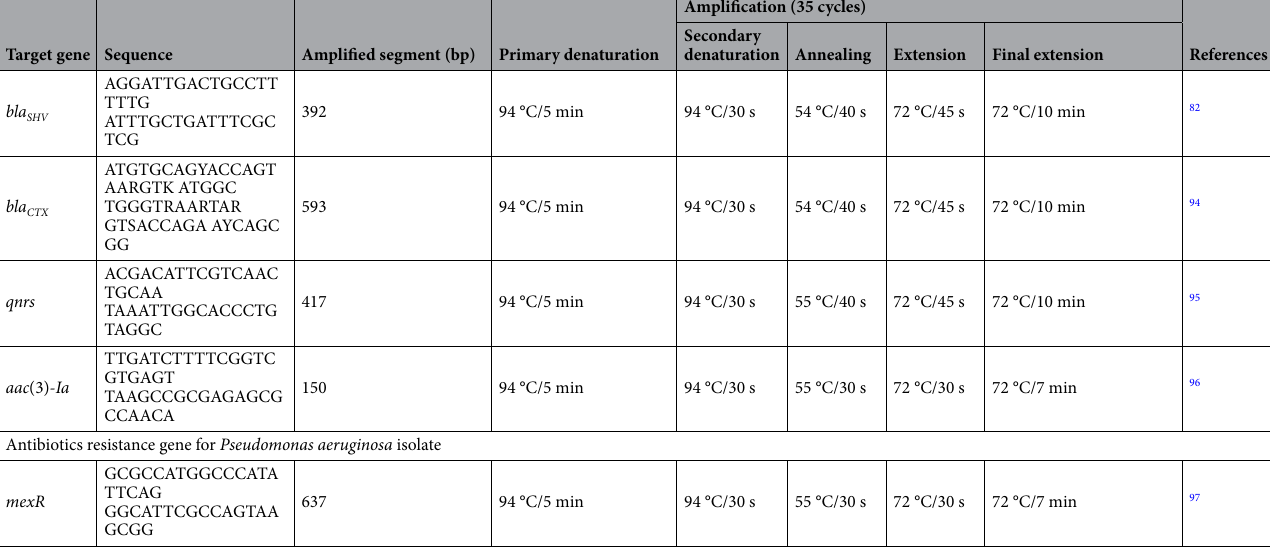
Table 5. Primers sequences, target genes, amplicon sizes and cycling conditions. The specific sequences that were amplified for each of the used primers (Metabion, Germany). a fim H gene was also detected for these isolates.